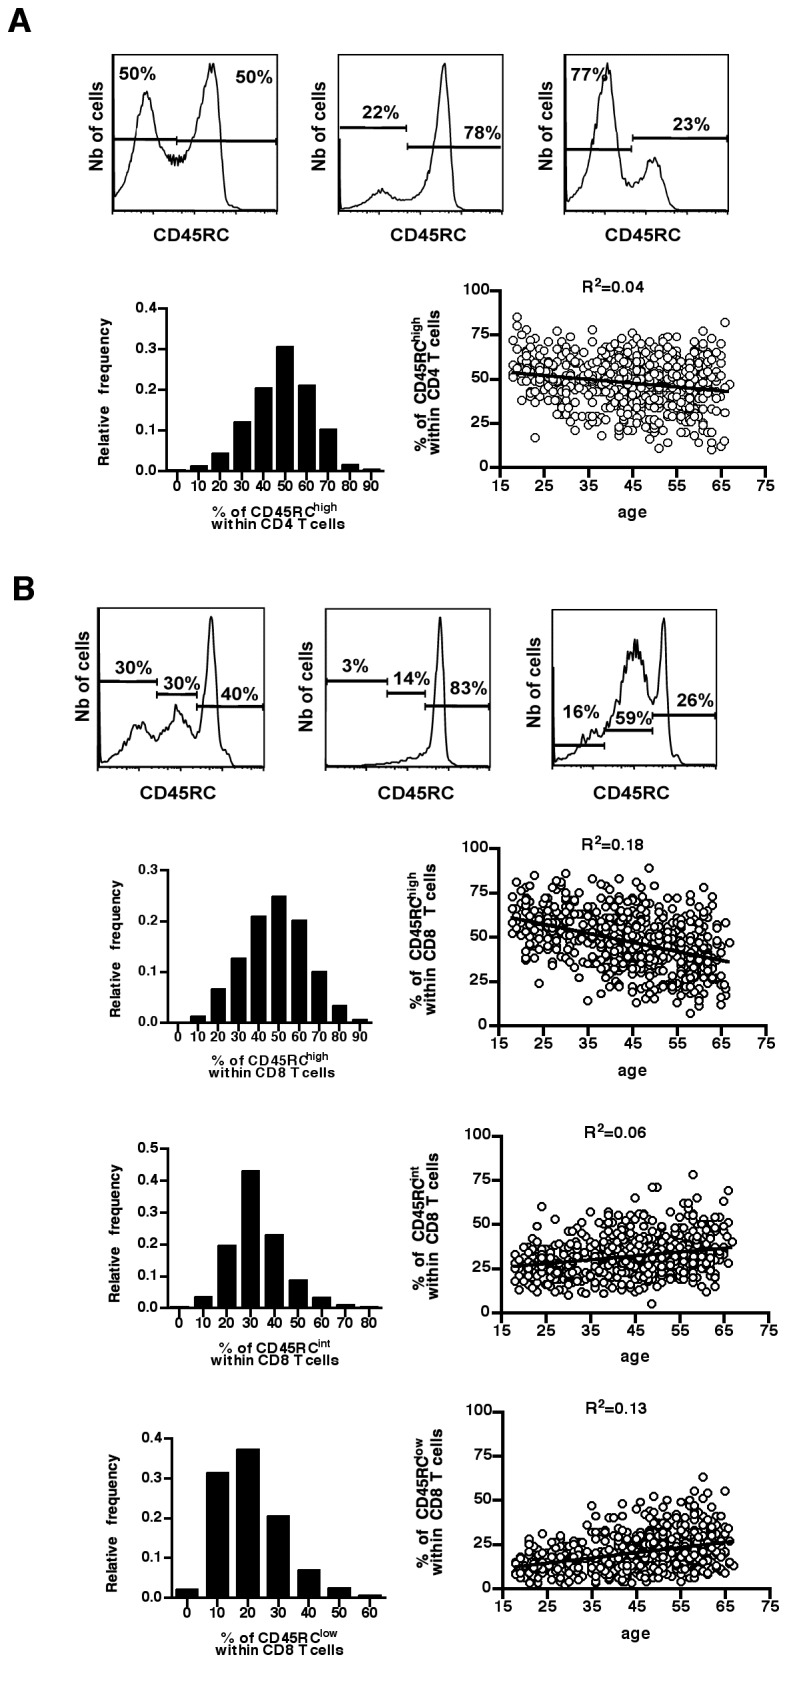
Distribution of CD4 and CD8 CD45RC T cell subsets in healthy individuals.Peripheral blood leukocytes from 608 healthy individuals were stained with mAbs against TCR, CD4, CD8 and CD45RC. The histograms represent CD45RC expression on CD4 T cells (A, top panels) and CD8 T cells (B, top panels) from three healthy individuals, to illustrate the inter-individual variability. The distribution of the proportion of CD45RChigh CD4 T cells (A) and of CD45RChigh, CD45RCint and CD45RClow CD8 T cells (B) in the cohort of 608 healthy individuals is presented as histograms. The proportion of CD45RC subsets in CD4 (A) and CD8 (B) T cells is presented according to age and each dot represents a separate individual. The R2 values were calculated using linear regression.